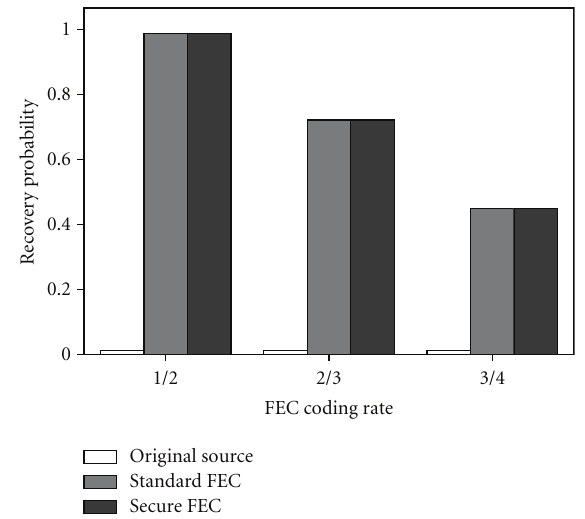
Figure 4: Comparison of recovery probability with varied FEC coding rates, when keeping k 1 = 12. The packet loss rate is fixed to 0.3.